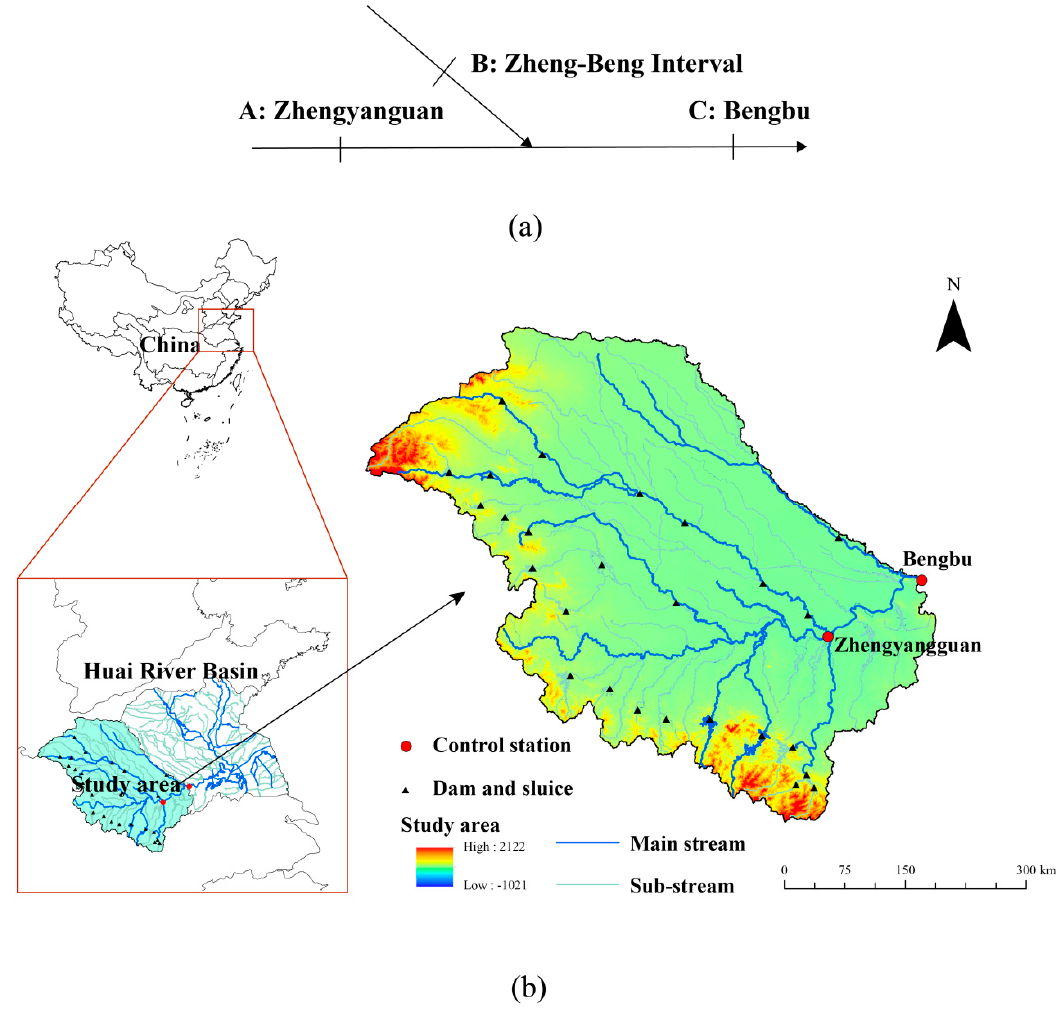
Figure 2. ( a ) Sketch map of a typical regional flood composition issue. ( b ) Location of Bengbu and Zhengyangguan hydrological stations in the Huai River basin.